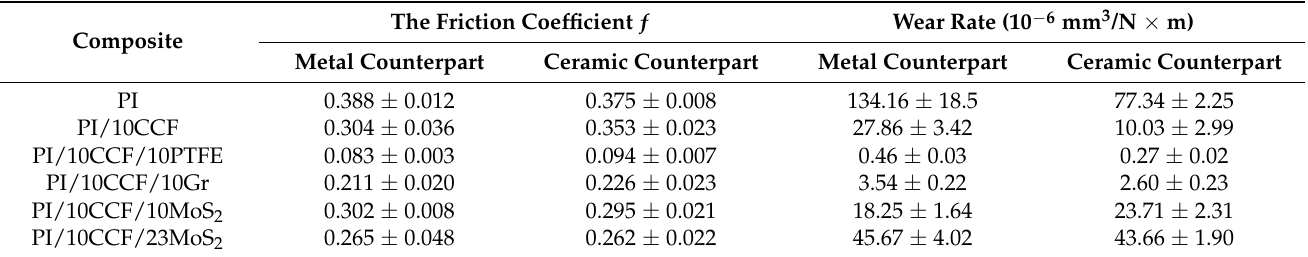
Table 3. The tribological characteristics of the PI-based composites ( P = 5 N; V = 0.3 m/s; the ‘pin-on-disk’ scheme).